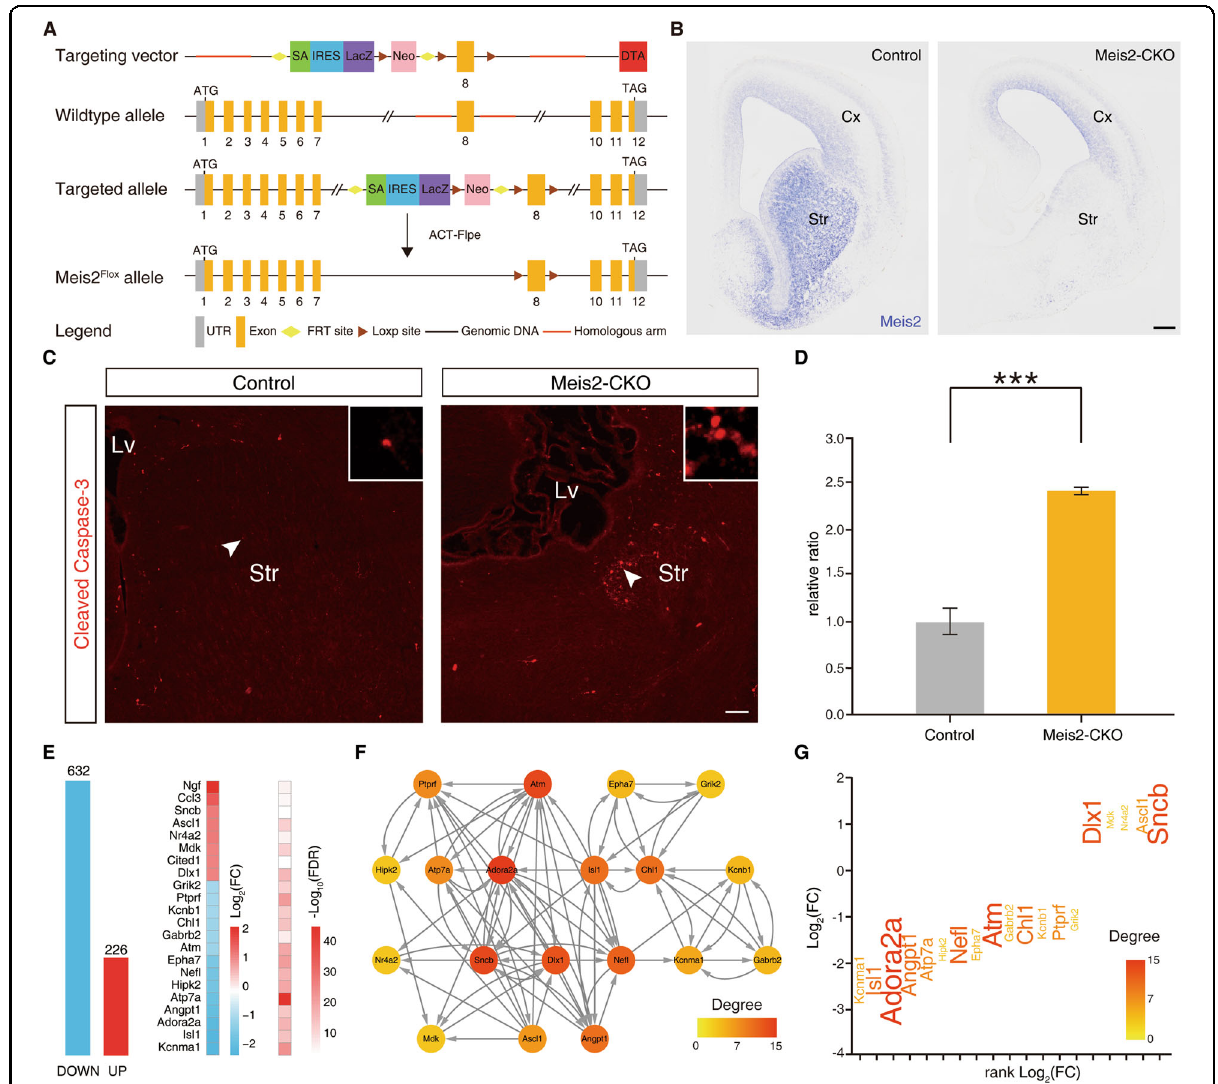
Fig. 6 Meis2 regulates neuronal apoptotic processes in the striatum. A The generation of the Meis2 Flox allele. The Meis2 gene-targeting vector was designed to delete exon 8 of Meis2. B Deletion of the Meis2 gene was con fi rmed at the mRNA level by in situ hybridization. C The immuno fl uorescence staining of cleaved Caspase-3 in Meis2-CKO striatum and controls at P0. Scale bars: 100 μ m in b and c. D Histogram showing that cleaved Caspase-3 + cells were increased in Meis2-CKO at P0. (Student ’ s t test, *** P < 0.001, n = 3 mice per group, mean ± SEM). Lv lateral ventricle. Str striatum. E Histogram of DEGs in the LGE between control and Meis2-CKO mice at P0. The 18 DEGs associated with “ regulation of neuron apoptotic process ” are shown. F A GRN of these “ regulation of neuron apoptotic process ” genes was inferred by Genie3. The edge direction represents the regulatory interaction from regulatory genes to target genes. Node size and color are proportional to the number of genes (in-degree and out-degree). G The signi fi cantly changed genes in Meis2-CKO mice compared to control mice are shown which are candidates for regulating the neuron apoptotic process. Genes are colored by their importance (degree) in the “ regulation of neuron apoptotic process ” GRN, and the gene font size increases with its